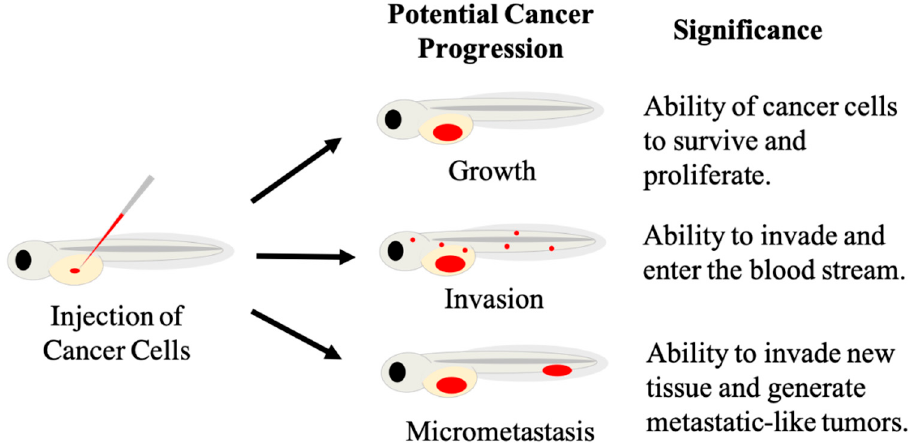
Figure 2. Diagram depicting measurable signs of cancer progression in zebrafish xenografts. Human fluorescent cancer cells (red) are injected into the yolk of embryonic zebrafish (left), with injected cells represented by the red oval. Cancer progression can display as growth, invasion or micrometastases (center). These phenotypic responses can be measured to provide information on specific cancer behavior, and responses of cancer cells to different treatments.